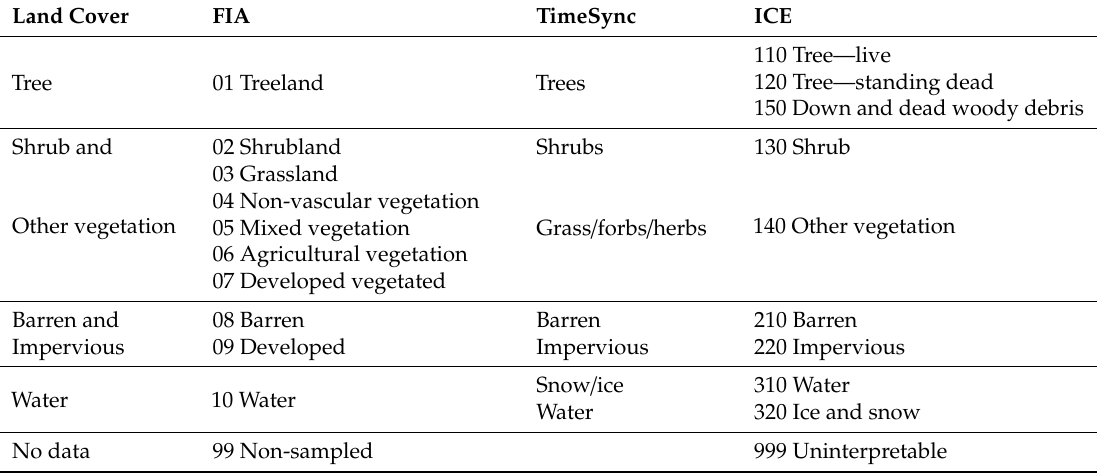
Table A2. Crosswalk of land use categories to four broad groups used for